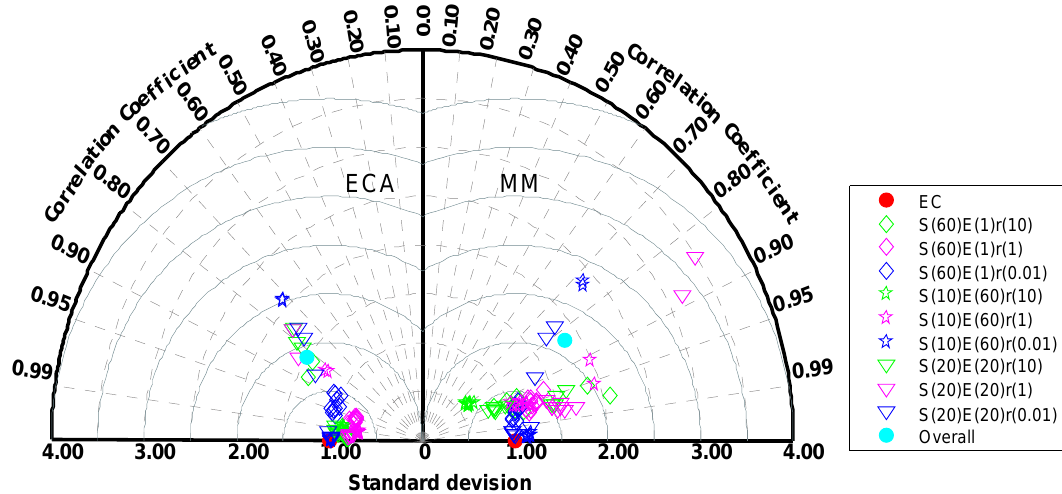
Fig. 3. A Taylor diagram based summary of the random sampling experiment (E1) that compared the ability of the ECA and the MM kinetics to approximate different enzyme–substrate networks simulated by the EC kinetics. Each symbol has 10 random replicates. The values in the parentheses indicate the number of substrates or enzymes. The nomenclature S ( x ) E ( y ) r ( z ) indicate a network of x substrates, y enzymes, and a substrate to enzyme abundance ratio of z .